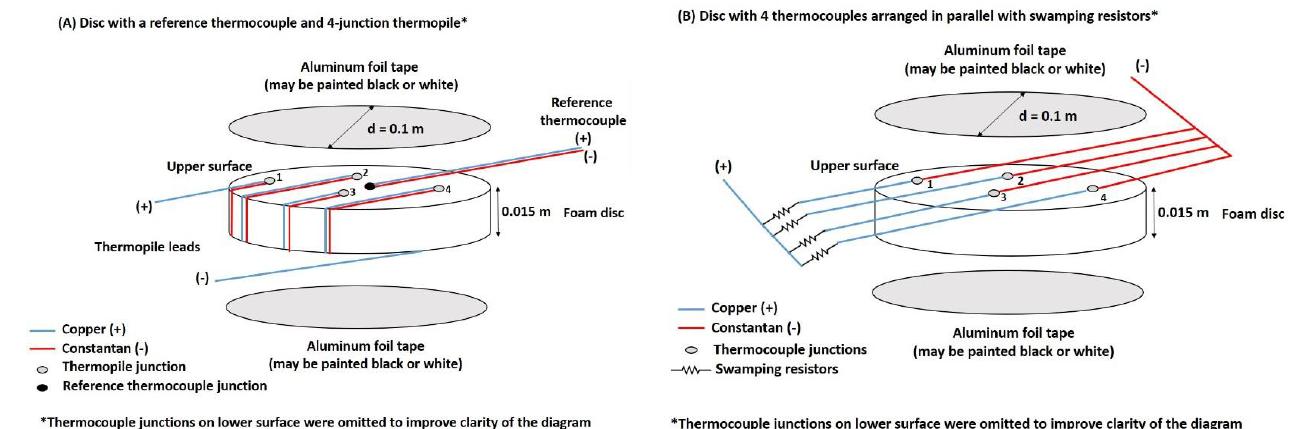
Figure 1. Diagram showing thermocouple arrangements for surface temperature measurement. When arranged in ( A ) series thermocouples form a thermopile, when arranged in ( B ) parallel swamping resistors are necessary.